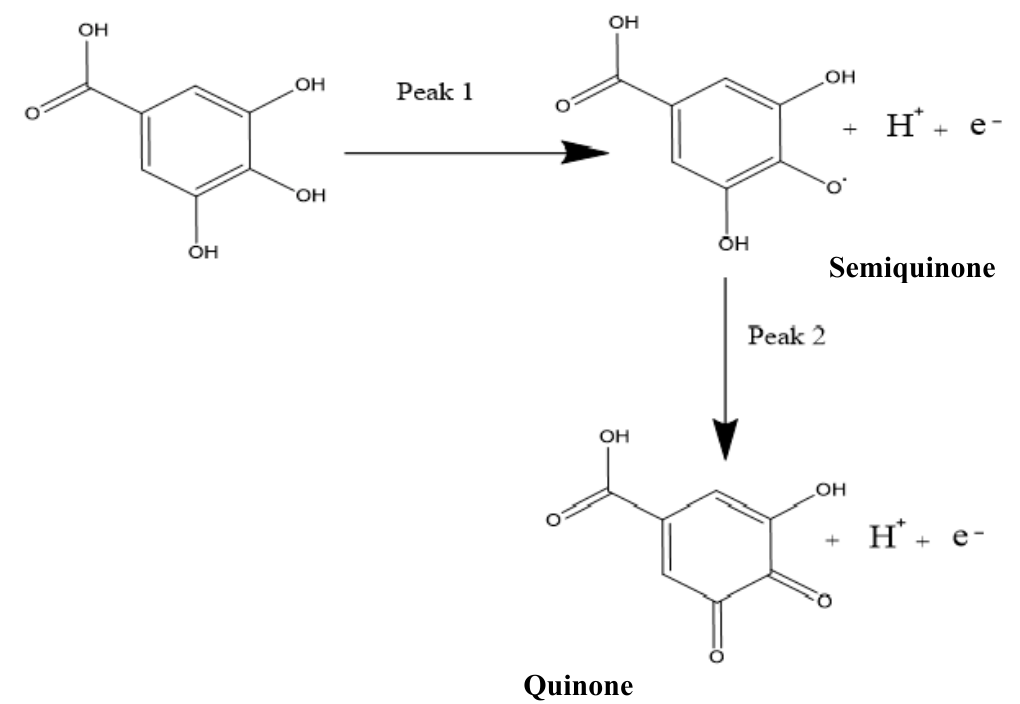
Figure 6. The reaction mechanism of the oxidation of gallic acid, showing the two peaks in cyclic voltammetry (CV) and differential pulse voltammetry (DPV).